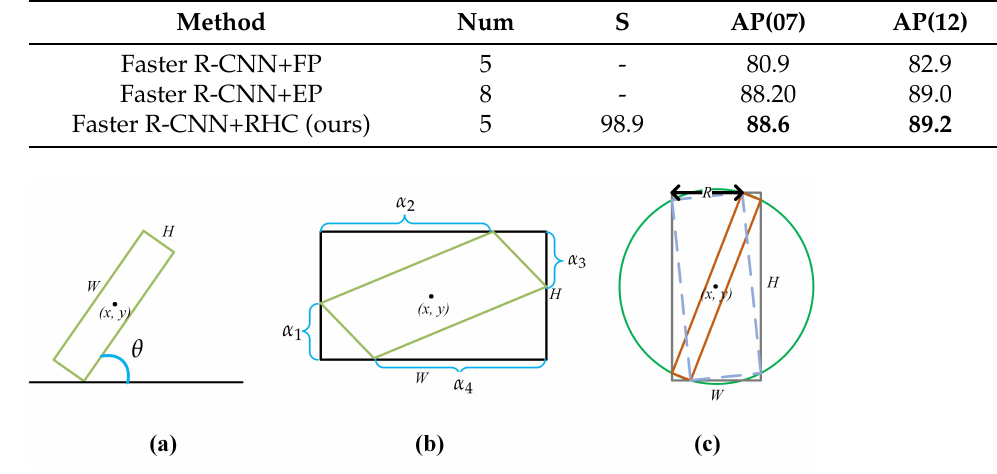
Figure 9. ( a ) The tilt target represented by ( x , y , w , h , θ ) ; ( b ) the tilt target represented by ( x , y , w , h , α ) ; ( c ) the tilt target represented by ( x , y , w , h , R , S ) . 1 , α 2 , α 3 , α 4